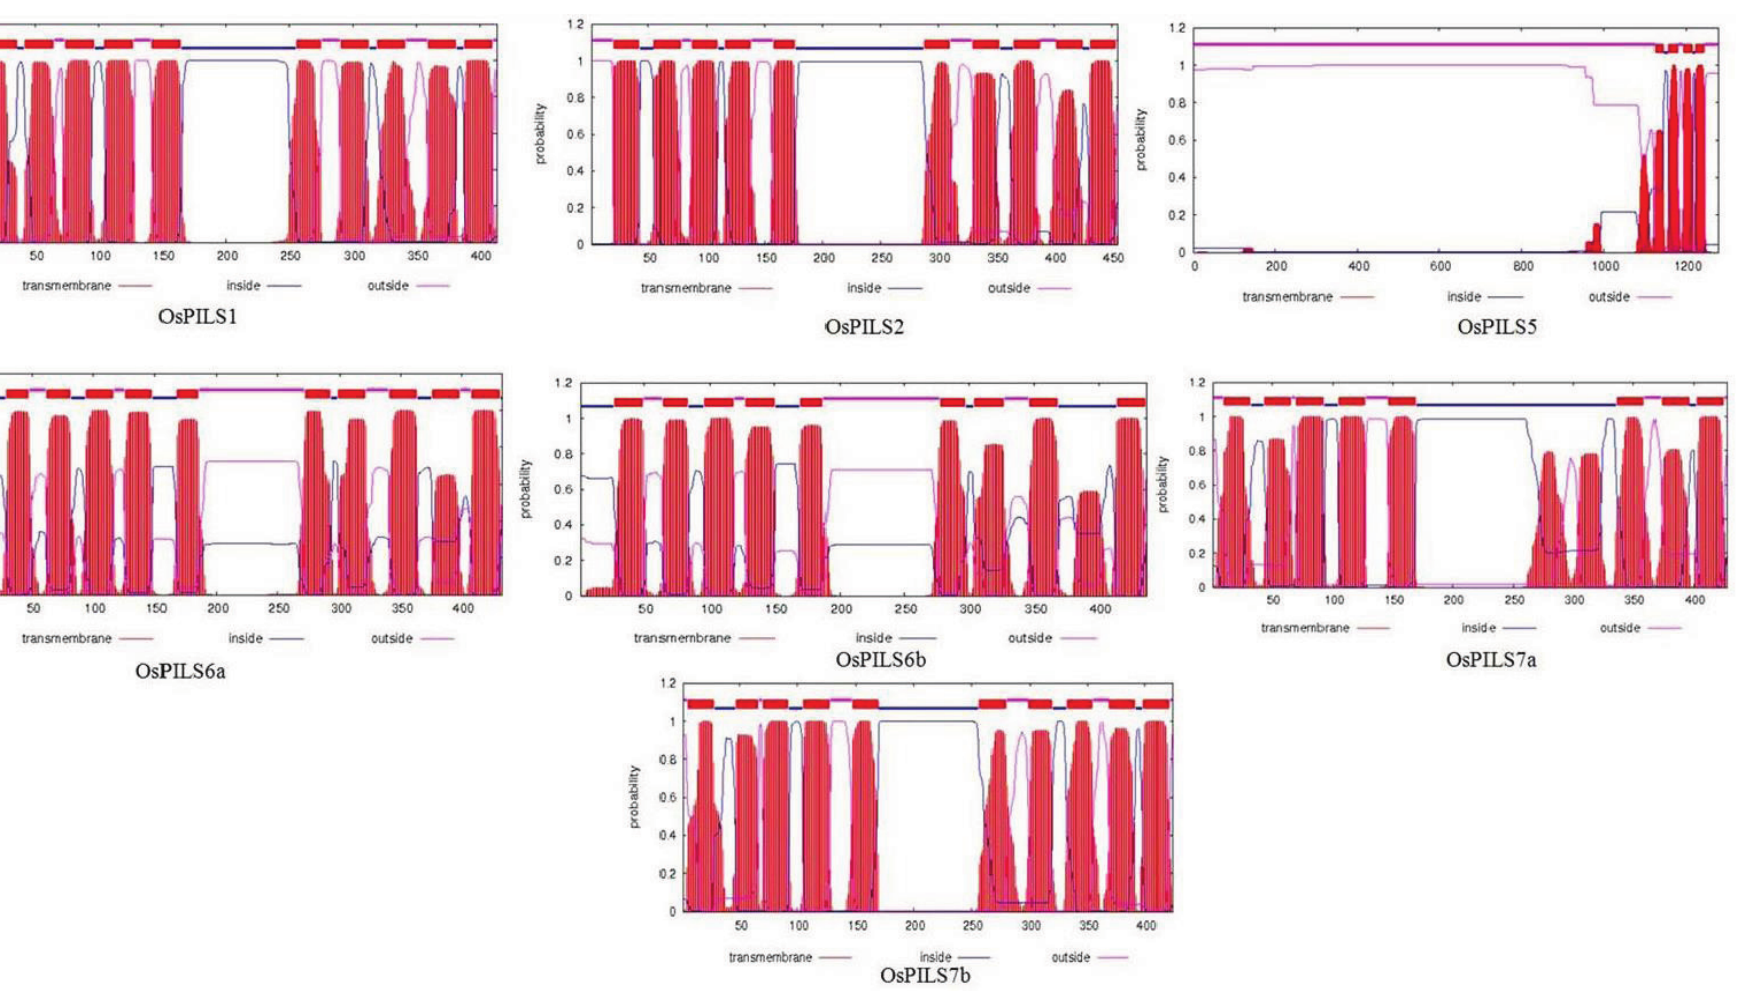
Figure 5. The prediction of transmembrane domains of OsPILS genes using TMHMM server 2.0). The prediction shows that maximum of OsPILS genes contained a short transmembrane